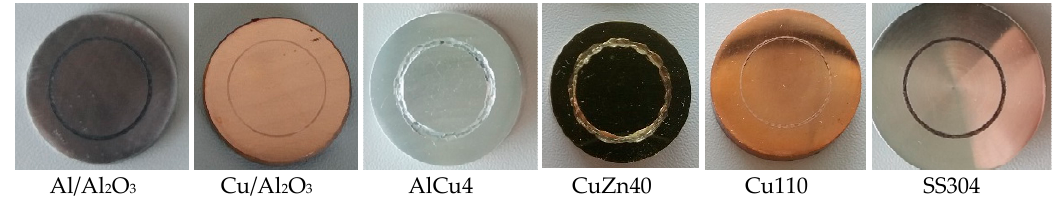
Figure 10. Macrographs of the wear traces of the cold-sprayed MMC coatings and reference metal alloys. Metals 2020 , 10 , x FOR PEER REVIEW